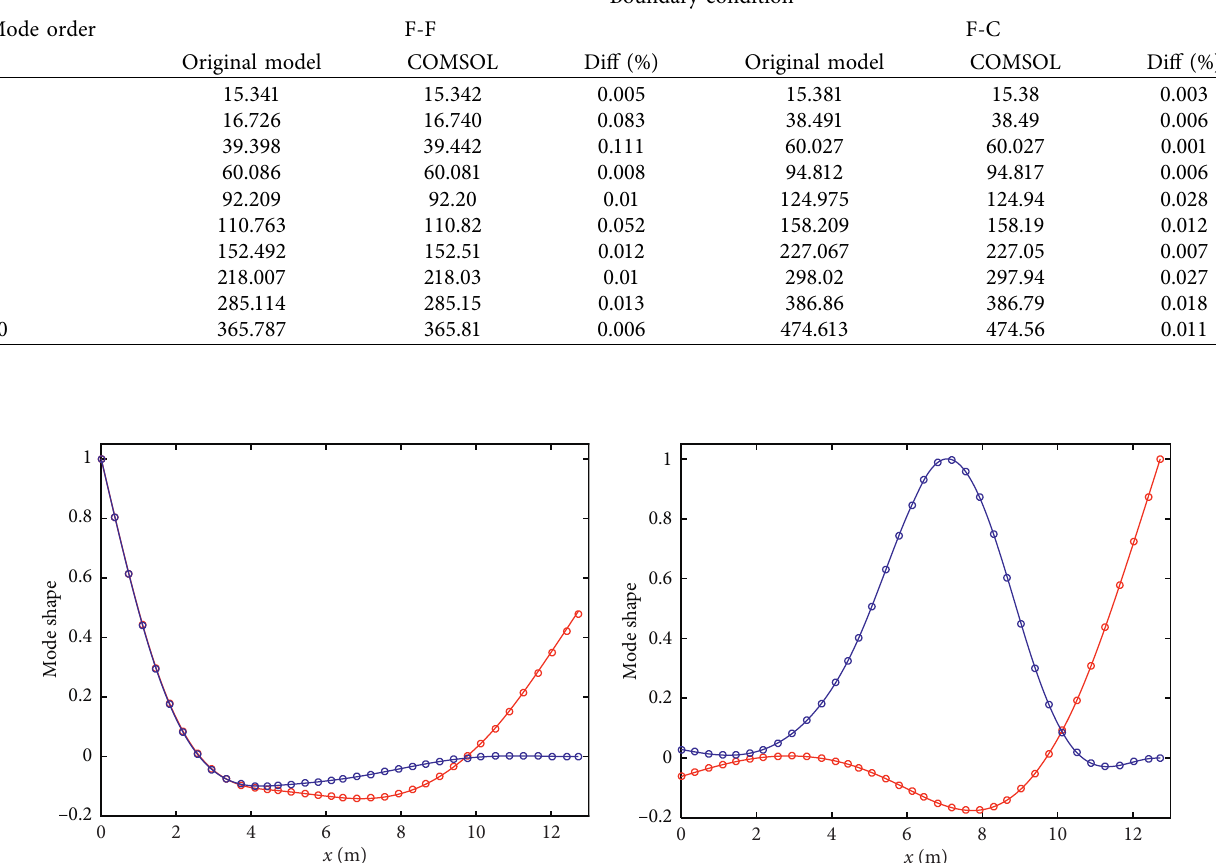
Table 2: The first ten modal frequencies of the original model with F-F and F-C boundary conditions. Mode